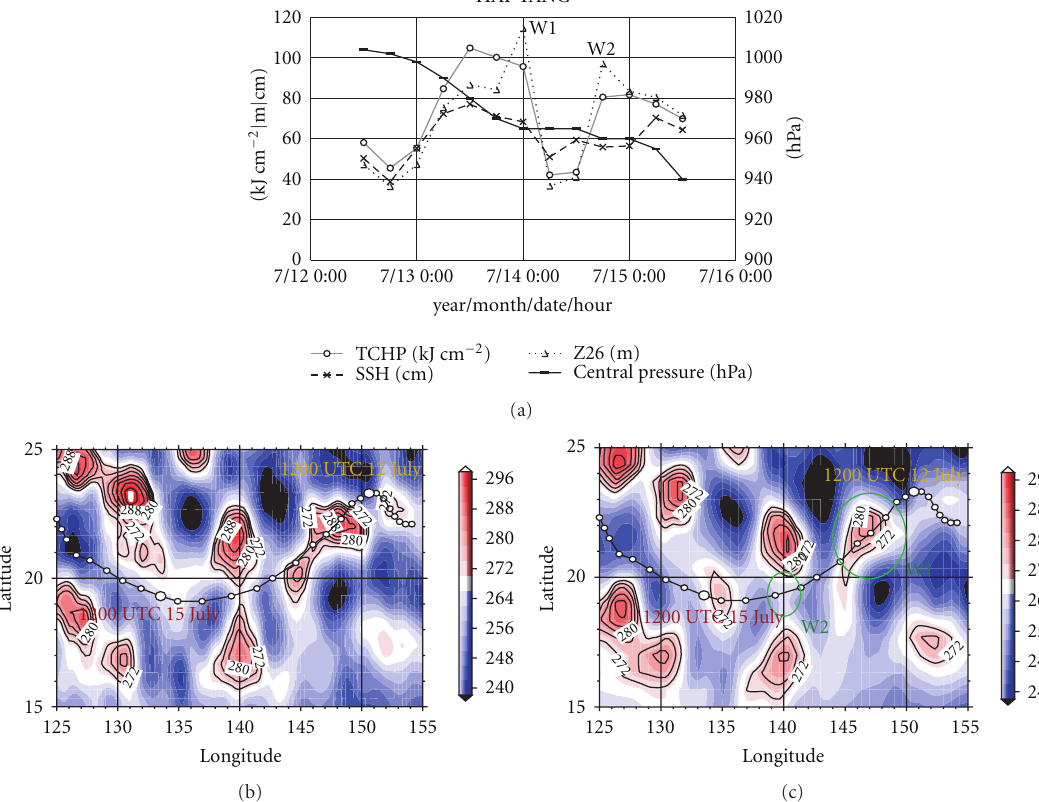
Figure 1: (a) Time series of best-track central pressure, tropical-cyclone heat potential (TCHP), 26 ◦ C isotherm depth (Z26), and sea surface height (SSH) from 1200 UTC 12 July to 1200 UTC 15 July 2005. (b) Horizontal distribution of the 7-day mean SSH (cm) obtained from the Archiving and Validating Interpretation of Satellite Oceanographic (AVISO) data product (ftp://ftp.aviso.oceanobs .com/pub/oceano/AVISO/SSH/duacs/global/dt/ref/madt/merged/h/) for 13 July 2005. (c) Horizontal distribution of daily SSH (cm) calculated by the MOVE system and corrected to make the 7-day spatial mean of the daily MOVE SSH equal to that of the AVISO SSH. W1 and W2 in part (a) and the green circles in part (c) indicate the warm-core eddies. The large circles along Hai-Tang’s track in parts (b) and (c) indicate the start and end positions of the numerical